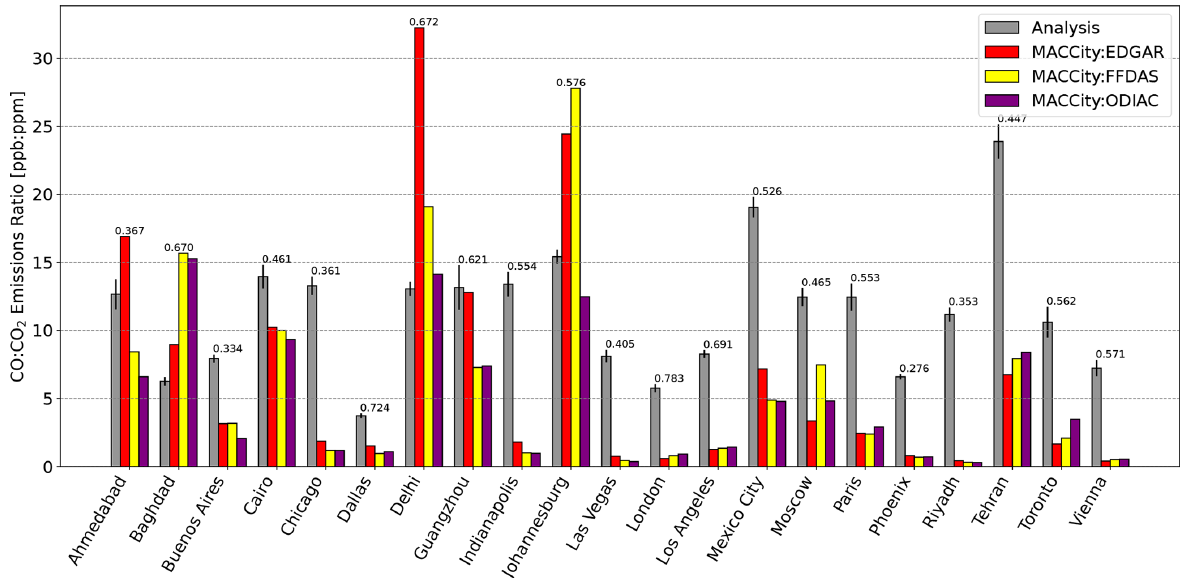
Figure A1. Same as is Fig. 6 but for enhancement ratios calculated using CO emissions from the MACCity inventory.